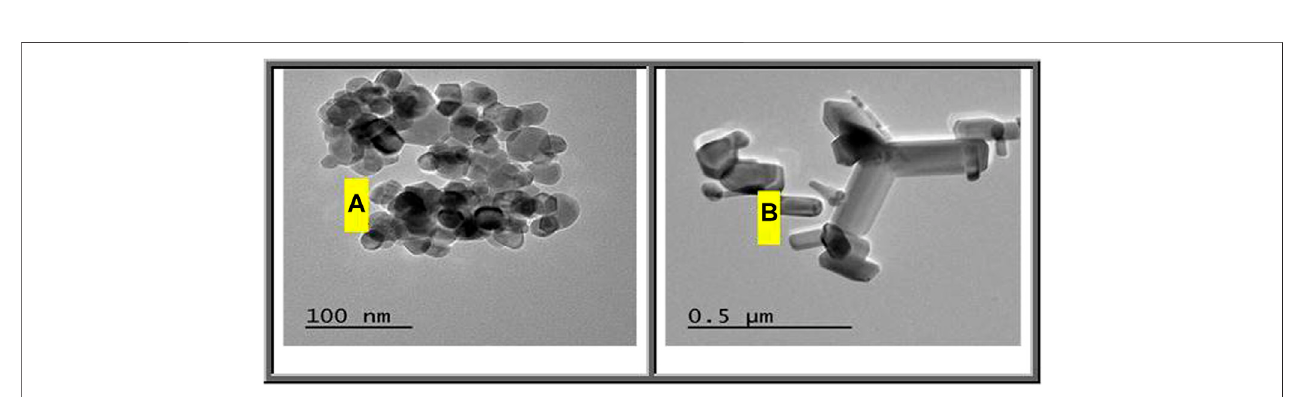
FIGURE 2 | TEM image of the synthesized (A) and commercial (B)